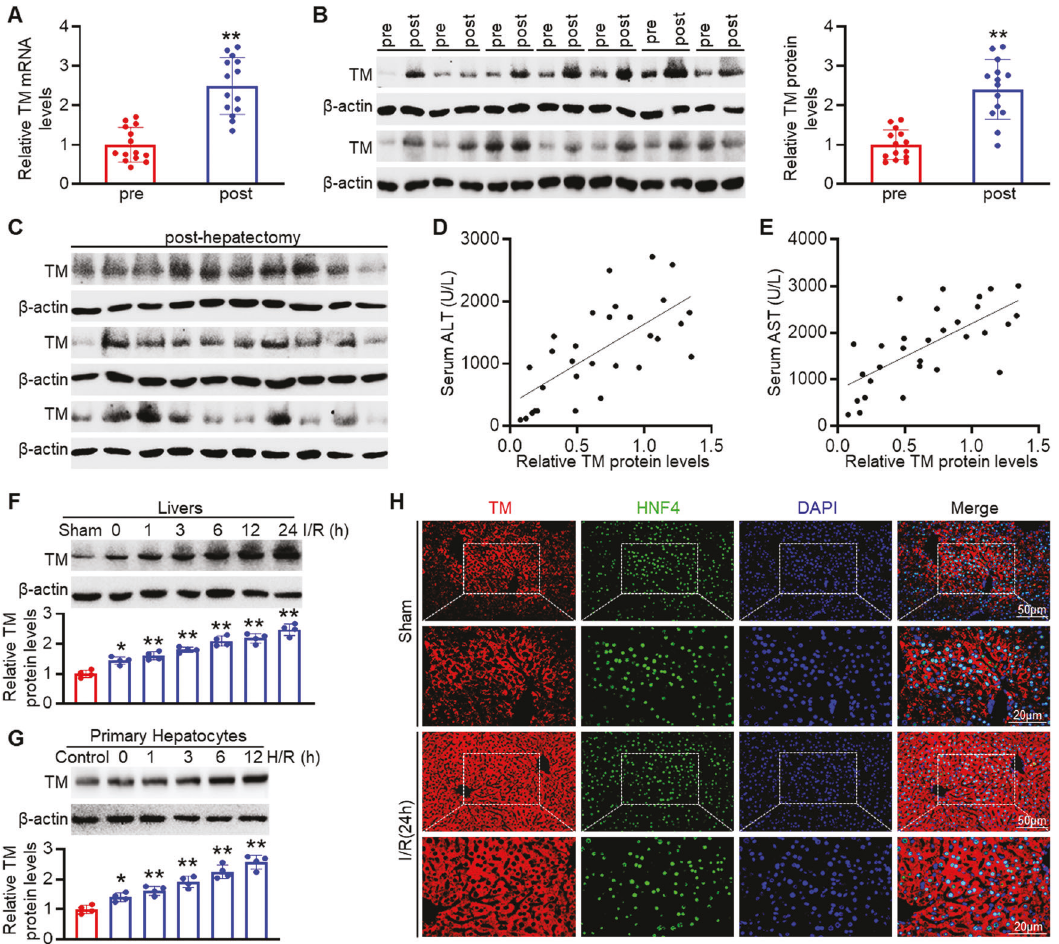
Fig. 1 Hepatic TMEM16A expression is increased during I/R liver injury. Levels of TMEM16A (TM) A mRNA and B protein in liver samples harvested from patients pre- and post-hepatectomy, with β -actin as the inner control ( n = 14). ** P < 0.01 versus pre-hepatectomy. C Western blot analysis of TMEM16A protein expression in human liver samples obtained post-hepatectomy ( n = 30). Pearson correlation analysis between post-hepatectomy hepatic TMEM16A protein expression and D serum ALT levels ( r 2 = 0.4701, P < 0.01) or E serum AST